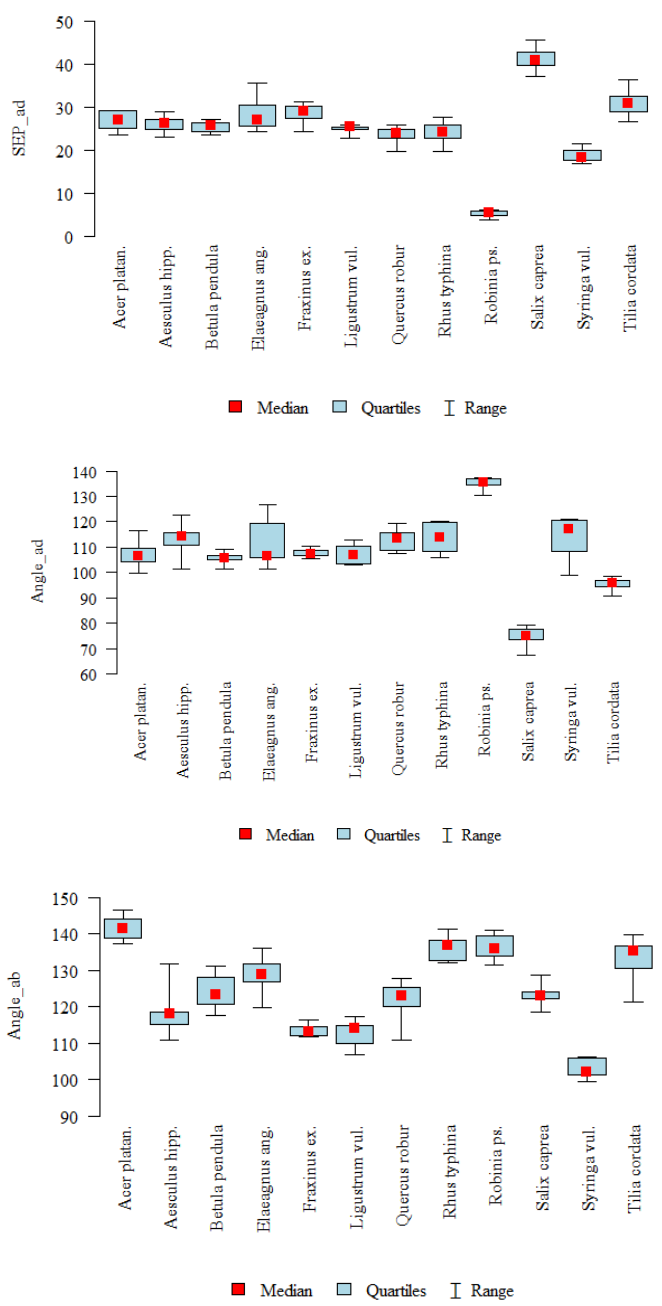
Figure 3. Medians, quartiles and value ranges of individual variables.Wax—the leaf wax content; S—canopy water storage capacity; SFP_ad—surface free energy of the upper leaf surface; SFP_ab—surface free energy of the lower leaf surface; Angle_ad—angle of contact with the upper leaf surface (adaxial side); Angle_ab—droplet angle of contact with the lower leaf surface (abaxial side);. p values are lower than 0.05 for all parameters, so the analysed species di ff ered significantly in all 3.3. The Remaining Relationships parameters. To answer the question of what exactly this relationship looks like, the post-hoc analysis was performed. The table has letter symbols for the following species: A— Acer platan. ; B— Aesculus hipp .; C— Betula pendula ; D— Elaeagnus ang .; E— Fraxinus ex .; F— Ligustrum vul .; G— Quercus robur ; H— Rhus typhina ; I— Robinia ps. ; J— Salix caprea ; K— Syringa vul .; L— Tilia cordata